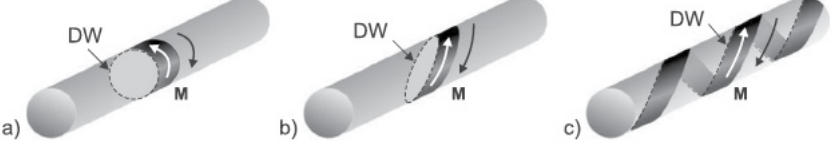
Figure 9. Three typical domain structures existing in microwires. ( a ) Circular structure, ( b ) elliptical structure, ( c ) spiral structure. Arrows show the direction of magnetization in domains. Dashed lines show the domain walls. Reprinted with permission from [54].